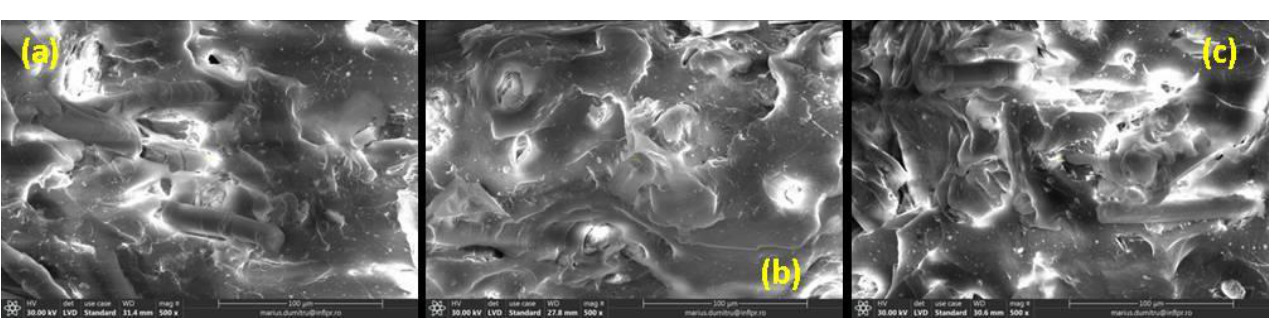
Figure 9. SEM micrographs of non-irradiated NR-S sample ( a ) and irradiated at 150 kGy ( b ) and 450 kGy ( c ) (magnification of 500).